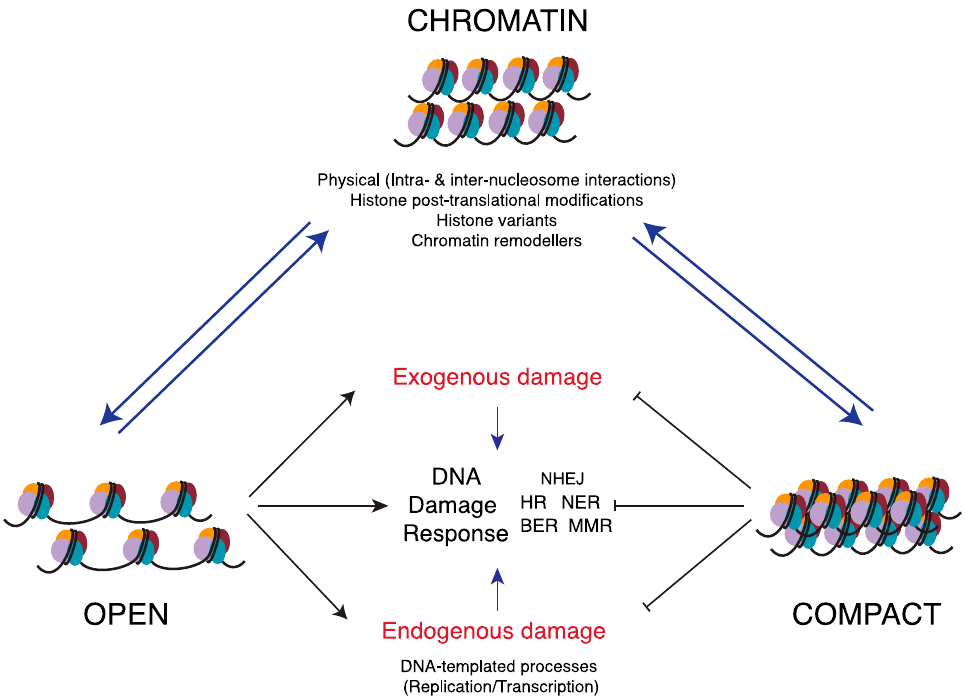
Figure 1. Chromatin structure dynamics regulate genome stability. Chromatin structural organization is dynamically controlled by intra- and inter-nucleosomal interactions, histone post-translational modifications (PTMs) and histone variants, and activity of ATP-dependent chromatin remodelers. All these factors ensure proper chromatin conformation during various stages of cell cycle and during various DNA-templated process. A more relaxed or “OPEN” chromatin conformation is prone to both exogenous and endogenous damage while at the same time leads to enhanced DNA damage response (DDR). The more compact or “CLOSED” chromatin conformation suppresses both kinds of genomic insults, however, it is generally inhibitory to DDR. Apart from DNA repair, the “CLOSED” chromatin conformation is also inhibitory to other DNA-templated processes such as transcription and replication. Therefore, the dynamic nature of chromatin structure provides a way to not only repair DNA lesions but also allows access to cellular machineries to perform DNA-based processes and in turn maintain genome stability. NHEJ; non-homologous end joining, HR; homologous recombination, NER; nucleotide excision repair, BER; base excision repair, MMR; mismatch repair.